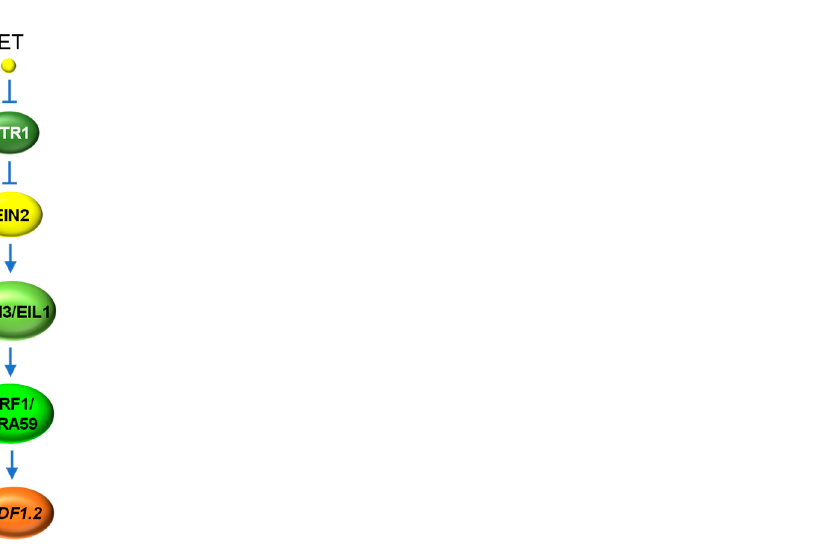
Figure 6. Simplified schematic of crosstalk between JA and ET signaling pathways. JA activates MYC2 to initiate wound and herbivory responses through the transactivation of defense genes, such as VSP2 . JA-mediated JAZ degradation also de-represses EIN3 and EIL1, the two master TFs of ET signaling, for the expression of other ERF TFs, such as ERF1 and ORA59, targets of which include pathogen defense genes, such as PDF1.2 . Additionally, MYC2 and EIN3 physically interact with each other and mutually inhibit each other’s transcriptional activities to balance between development and different defense responses. VSP2 , VEGETATIVE STORAGE PROTEIN2 ; PDF1.2 , PLANT DEFENSIN1.2 ; ERF1, ETHYLENE RESPONSE FACTOR1; ORA59, OCTADECANOID-RESPONSIVE ARABIDOPSIS59; EIN, ETHYLENE INSENSITIVE; EIL1, EIN3-LIKE1; CTR1, CONSTITUTIVE TRIPLE RESPONSE1.